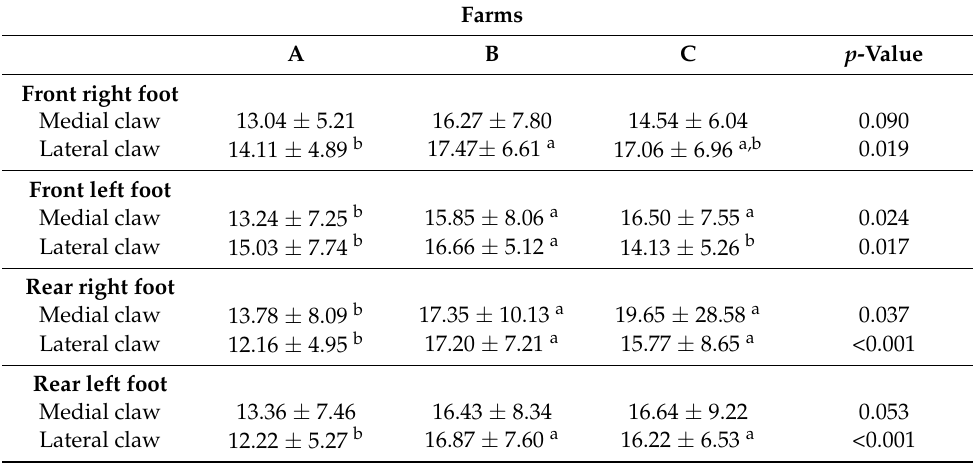
Table 2. Yield stress values (mean ± SD) in MPa of medial and lateral claws for all feet of culled sows from three genetic